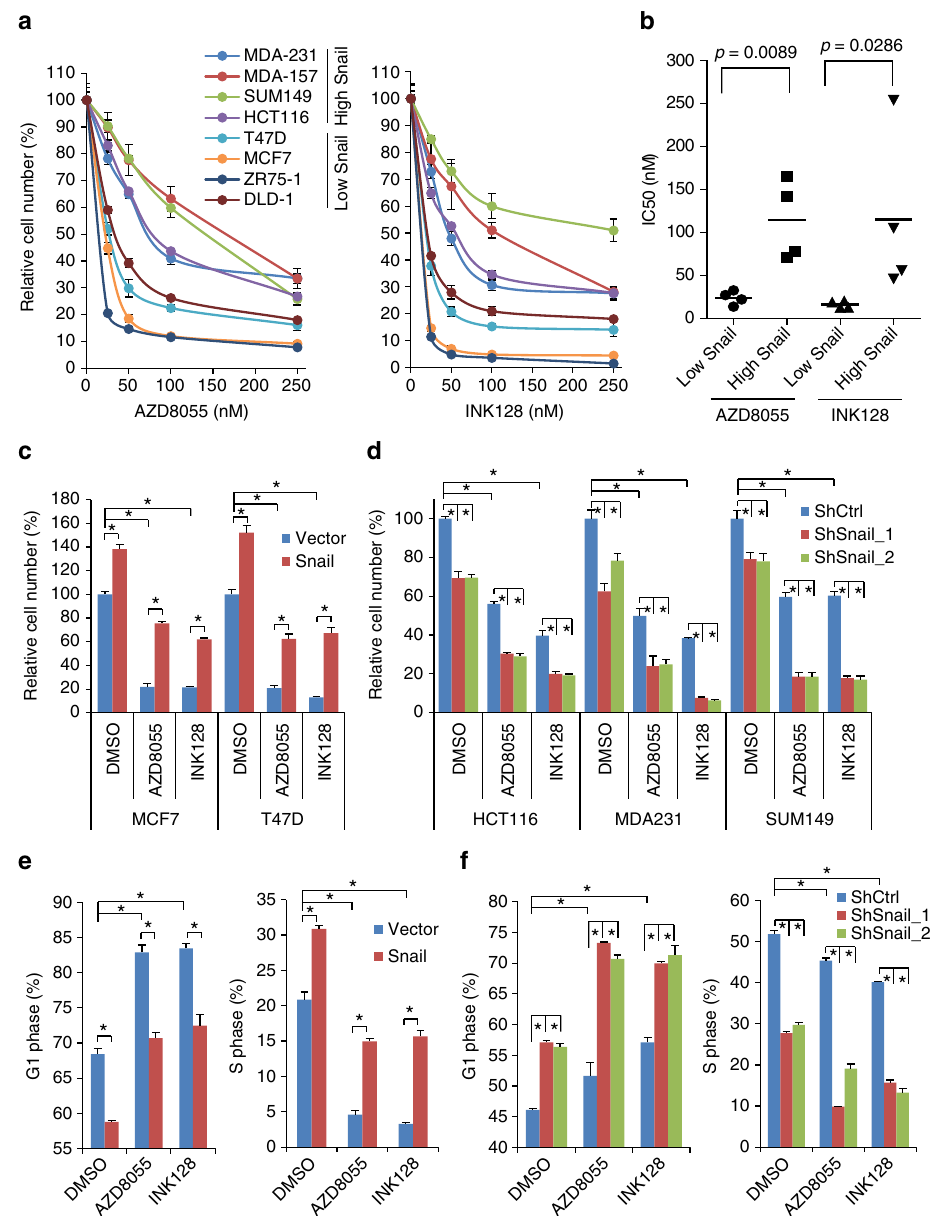
Fig. 5 Snail mitigates the anti-proliferative effect of mTOR kinase inhibitors. a , b Growth for the indicated cell lines was assessed after 72 h of treatment with AZD8055 or INK128 (0 – 250 nM). Results are expressed as a percentage of cell number relative to the DMSO-treated control cells a or as the half- maximal growth inhibitory concentration (IC50) for AZD8055 or INK128 b . c , d The growth of the indicated cells with stable expression c or knockdown d of Snail or their respective controls was assessed after 72 h of treatment with 100 nM AZD8055, 100 nM INK128 or DMSO as control. The results are expressed as a percentage of cell number relative to the DMSO-treated vector control cells c or shRNA control cells d . e , f T47D cells with stable expression of Snail or vector control e and MDA-231 cells with stable expression of Snail shRNA or control shRNA f were treated with 100 nM AZD8055, 100 nM INK128 or DMSO as control for 24 h, followed by cell cycle analysis using fl ow cytometry. The results are expressed as the percentage of cells in the G1 or S phase distributions. All graphic data are presented as mean ± SEM ( n = 3 technical replicates per condition). * P < 0.001 using Student ’ s t -test